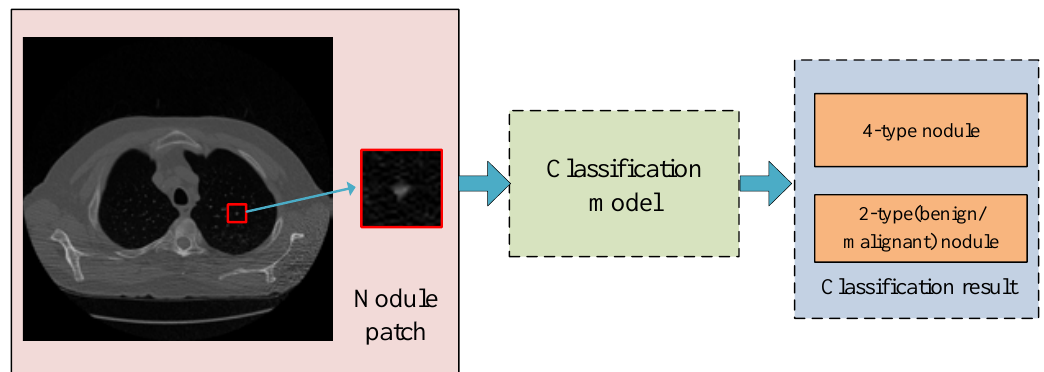
Figure 3. Problem statements of lung nodule classification in this research.